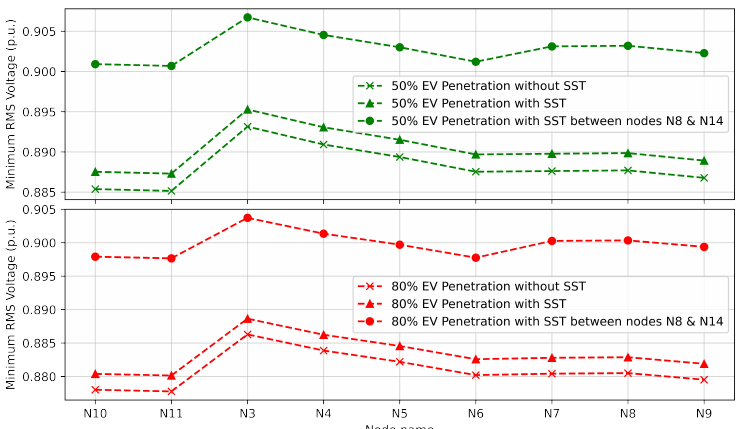
Figure 10. Comparison of minimum RMS voltages with SST at different placements.